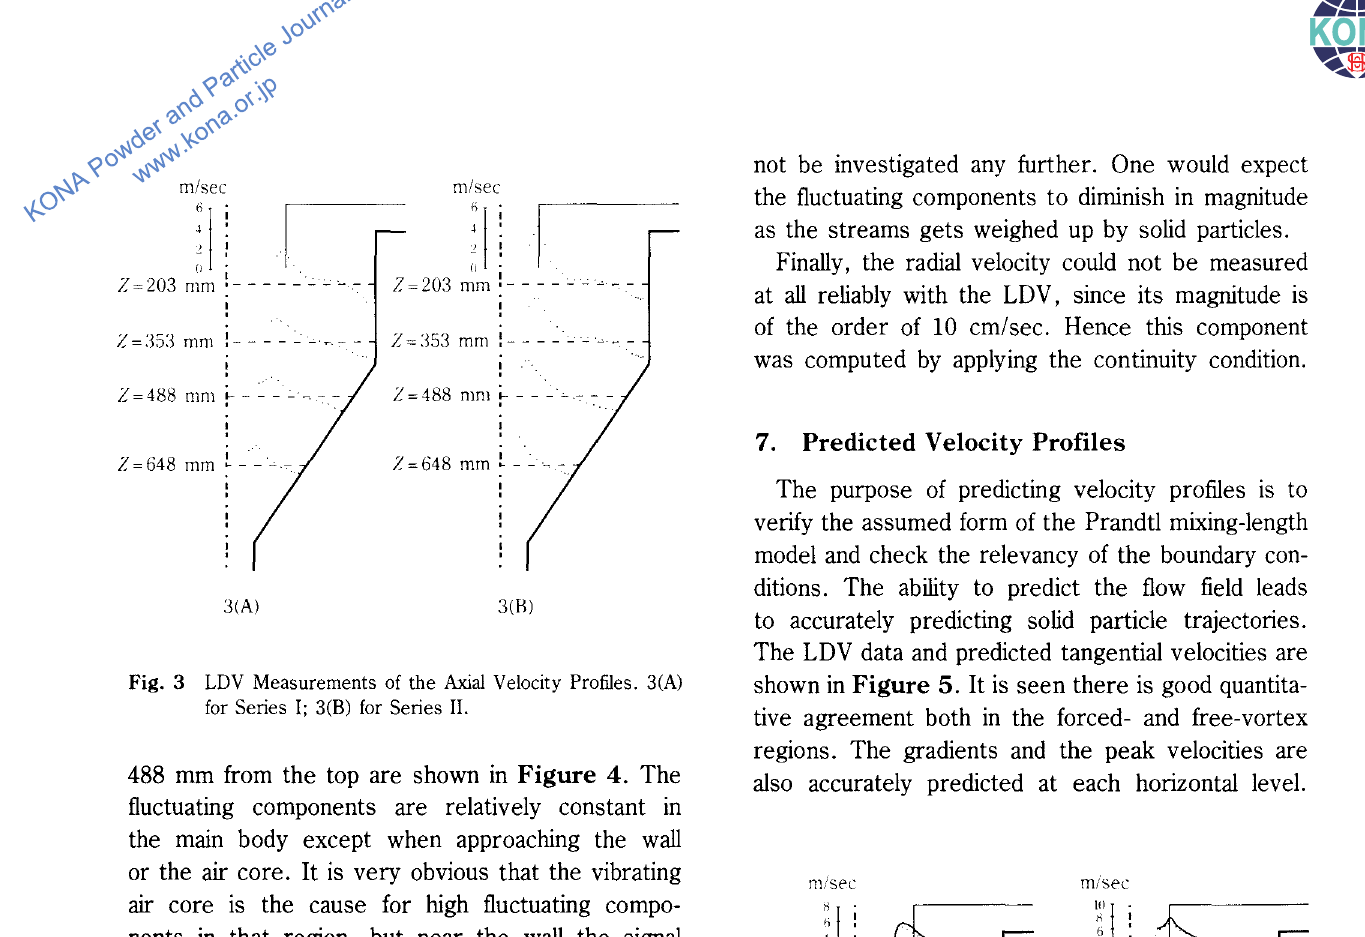
Fig. 3 LDV Measurements of the Axial Velocity Profiles. 3(A) for Series I; 3(8) for Series II.